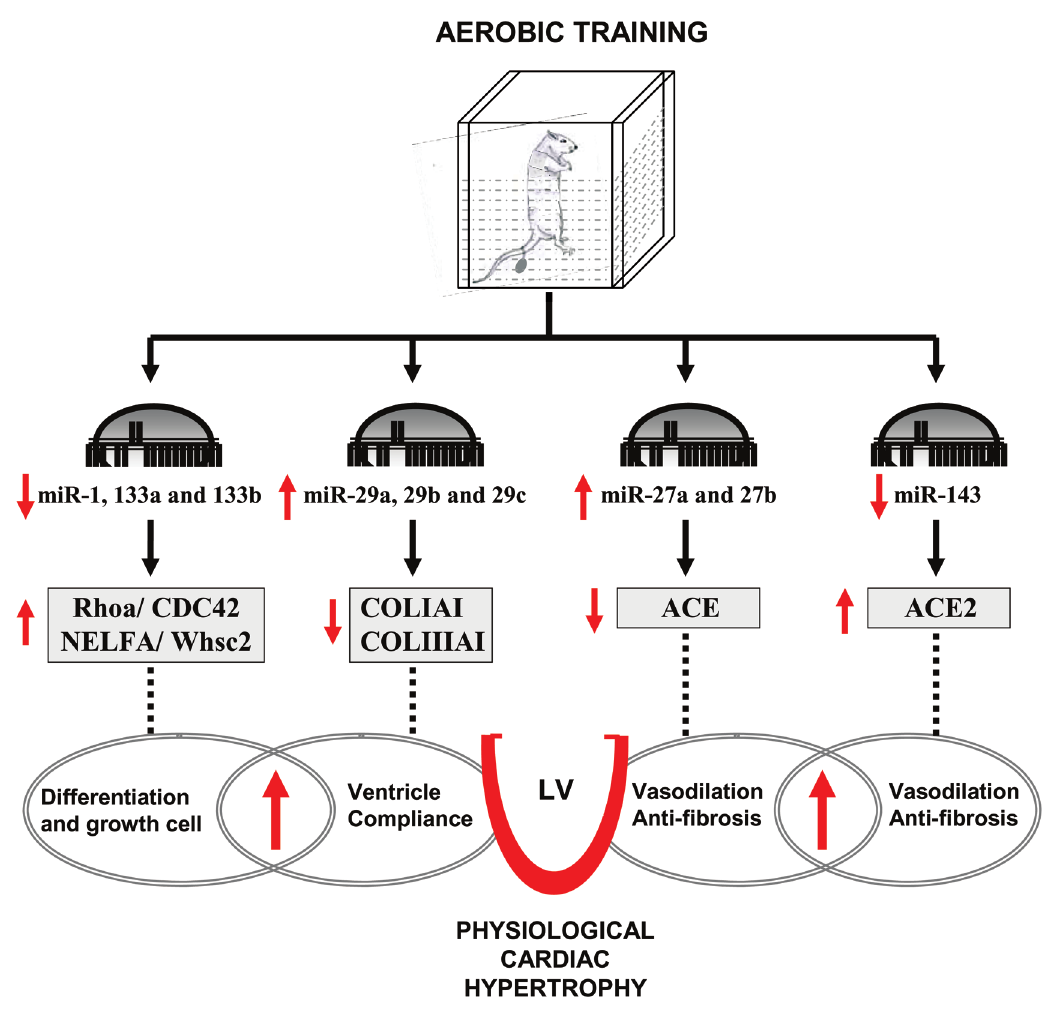
Figure 4. The regulation of miRs by aerobic training controls phenotypes that contribute to physiological cardiac hypertro- phy. Aerobic exercise training is a powerful stimulus modulating several miRs that regulate their target mRNAs, thereby contributing to the phenotype of physiological cardiac hypertrophy through different signaling pathways. Red arrows indi- cate points of up-regulation or down-regulation of miRs, proteins and cardiac function induced by exercise training. Rhoa = Ras homologue gene family-A; CDC42 = cell division control protein 42; NELFA protein/WHSC2 = Wolf-Hirschhorn syndrome candidate 2; COLI and COLIII = collagens I and III; ACE and ACE 2 = angiotensin-converting enzymes 1 and 2; miR =